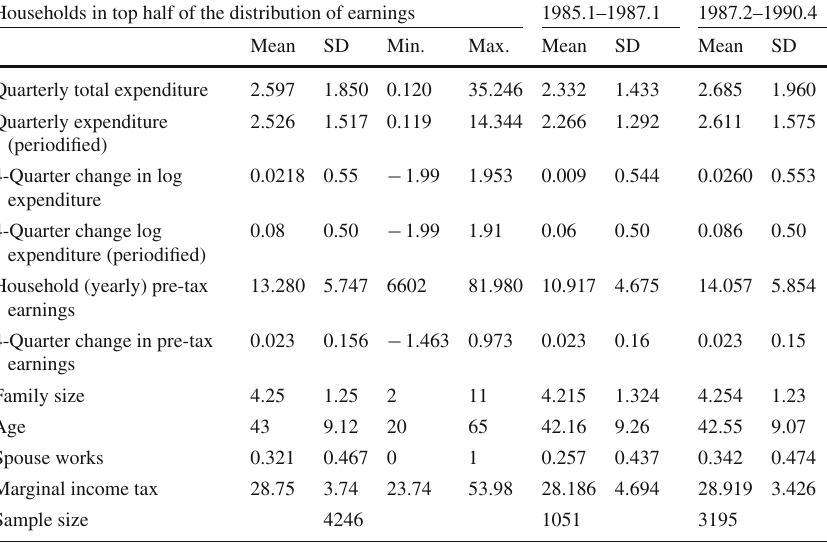
Table 3 Summary statistics, expenditure survey (ECPF)—top half of distribution of earnings Households in top half of the distribution of